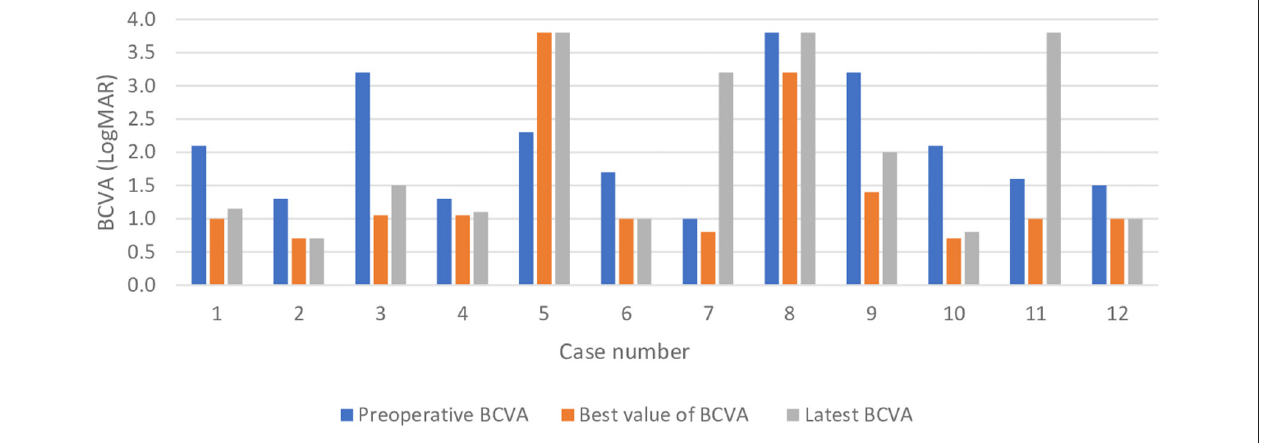
FIGURE 2 | Best corrected visual acuity changes in the